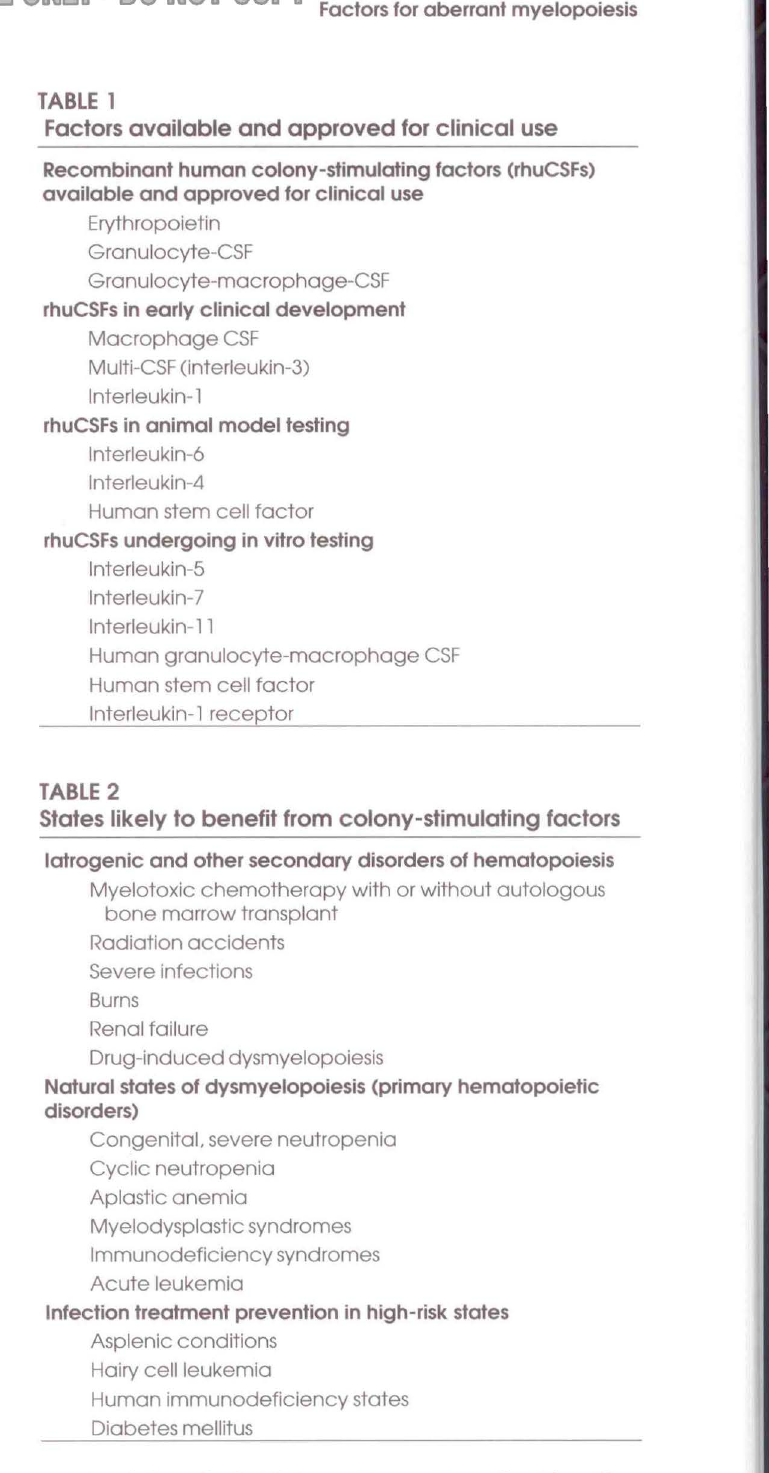
Factors available and approved for clinical use Recombinant human colony-stimulating factors (rhuCSFs) available and approved for clinical use